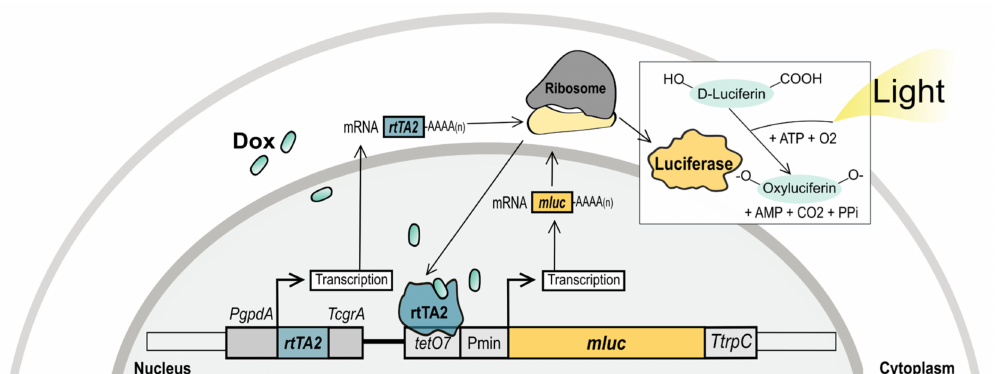
Figure 1. Model of the Tet-on mechanism to control the expression of mluc . Plasmid pVG3.1 contains the gene for the tetracycline-dependent transactivator rtTA2 S -M2 under control of the constitutive promoter of the glyceraldehyde-3- phosphate dehydrogenase gene from Aspergillus nidulans (P gpdA). In the presence of Dox, rtTA2 S -M2 binds to the operator sequence tetO7 , activates the fungal minimal promoter of P gpdA (Pmin), and consequently induces mluc gene expression. This gene encodes the enzyme luciferase that converts luciferin into oxyluciferin and emits